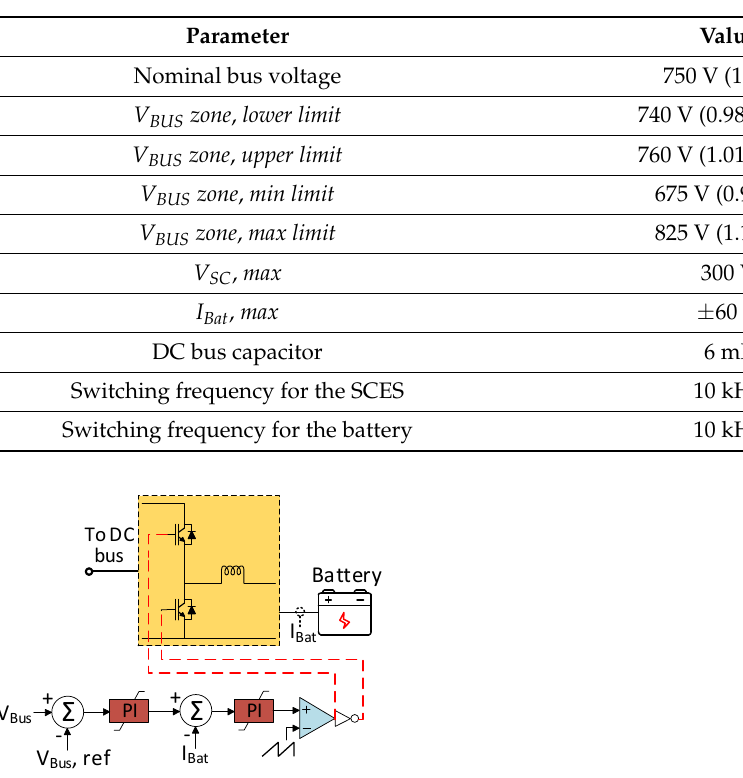
Table 5. The control parameters.